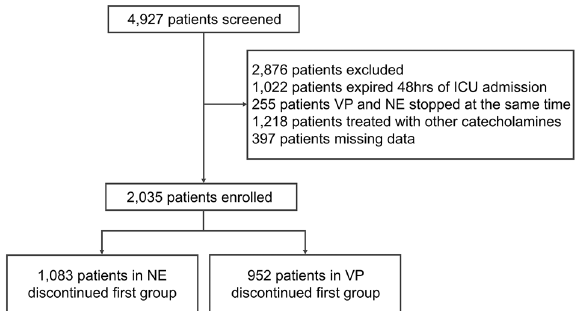
Figure 1. Study flow chart of patient